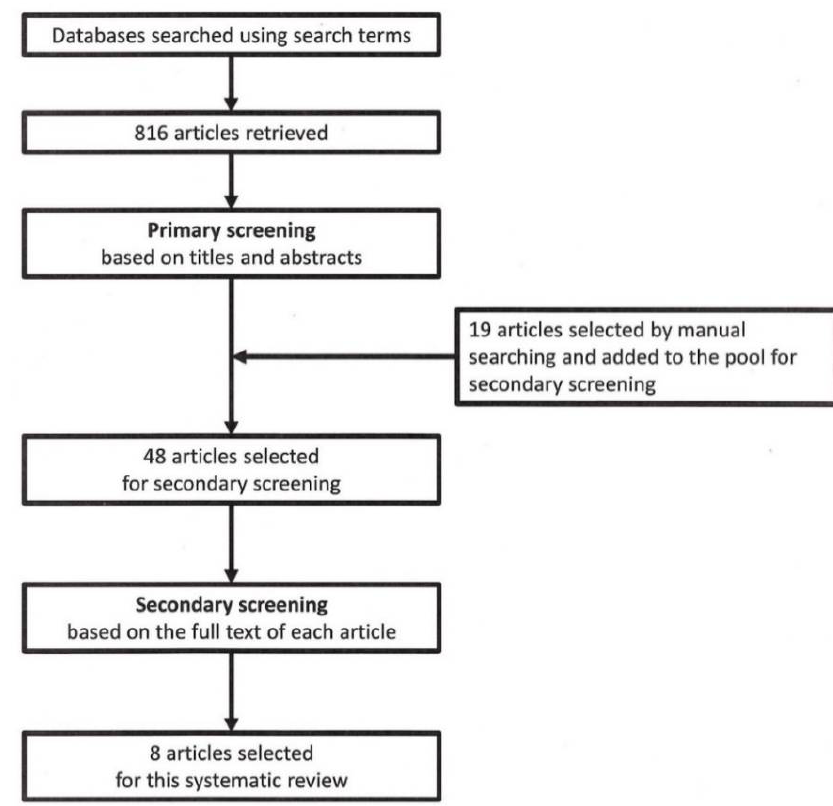
Figure 3. Flowchart of this systematic review.